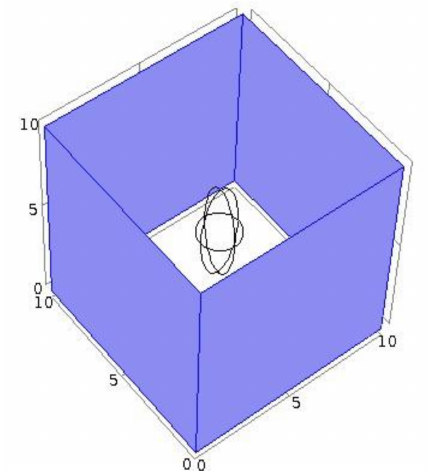
Figure 7. Zero charge boundary condition.